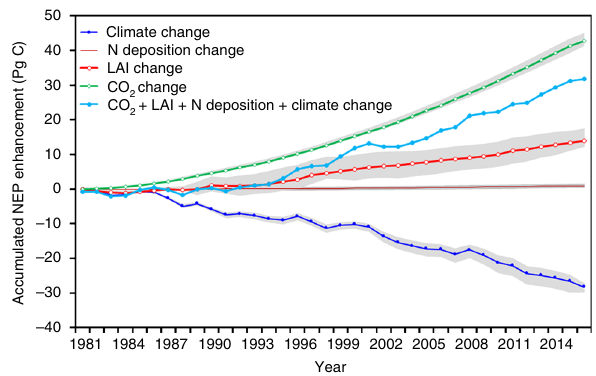
Fig. 3 The accumulated terrestrial carbon sink from 1981 to 2016, after subtracting the baseline sink of 62.1 Pg C due to long-term changes (legacy effects). Through numerical experiments, the variations of the accumulated sink with time due to the various drivers are calculated, showing that CO 2 fertilization (without LAI changes), LAI, nitrogen deposition, and climate are responsible for the sinks of 44.6, 11.7, 1.1, and − 27.1 Pg C over this period, respectively. These sinks contribute 47.0%, 12.4%, 1.1%, and − 28.6% to the total accumulated residual land sink (95 ± 5 Pg C) over this period, respectively. For example, the accumulated CO 2 enhancement is calculated by holding other drivers at the baseline, while changing CO 2 according to